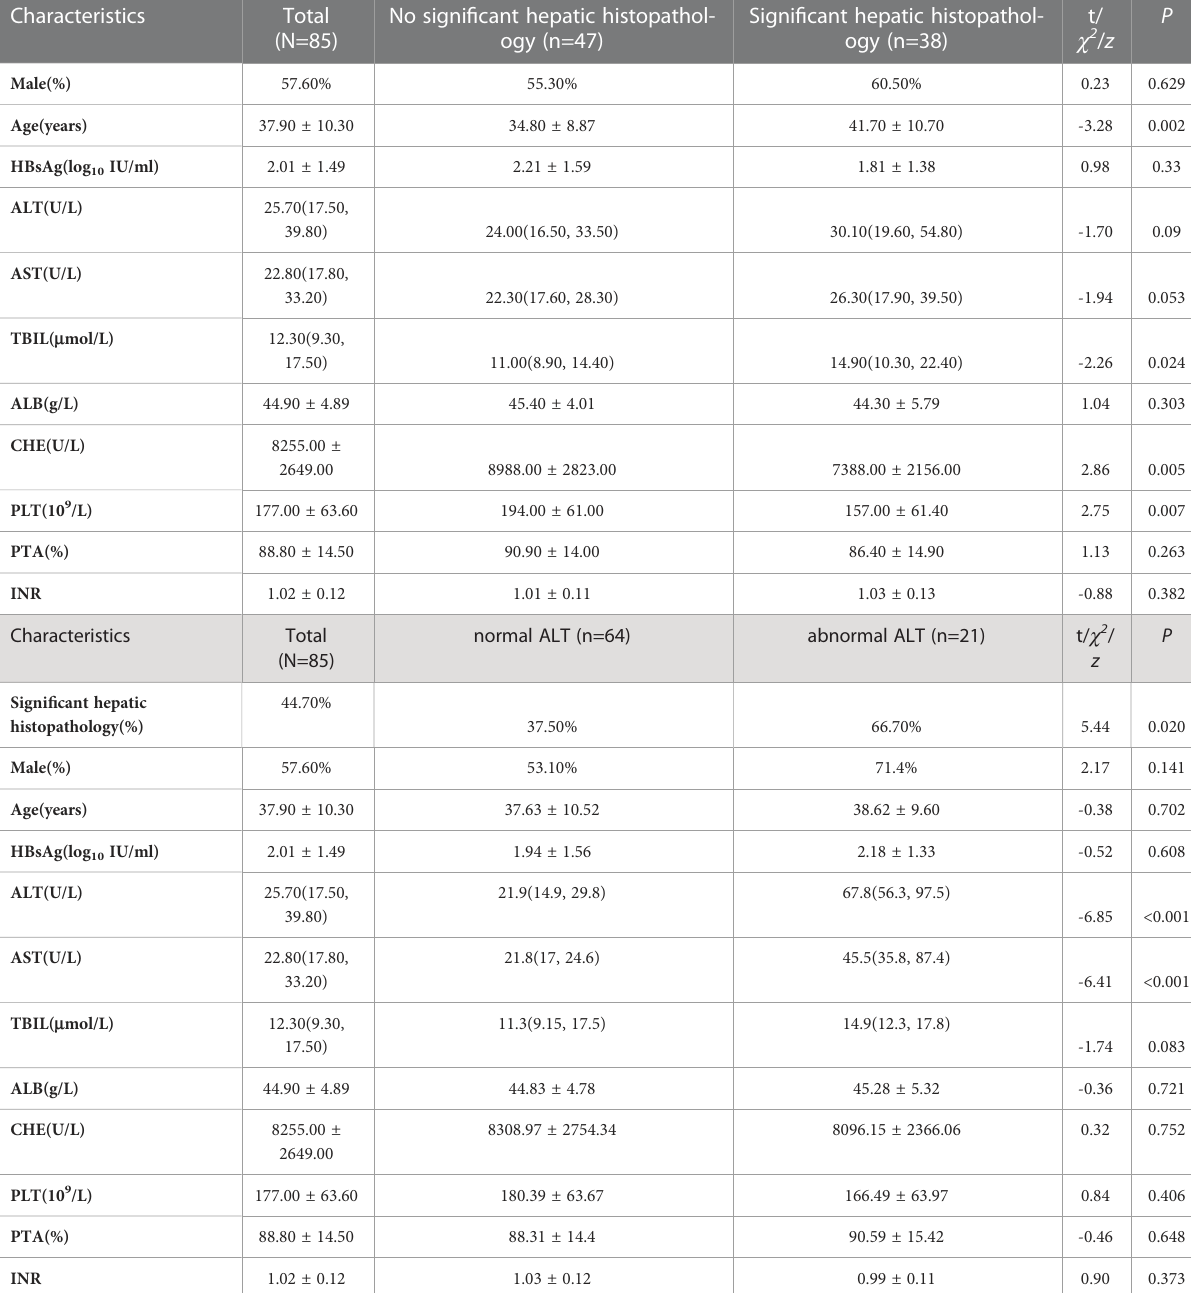
TABLE 1 Characteristics and comparison of clinical indicators in HBeAg-negative, HBV DNA-negative patients.